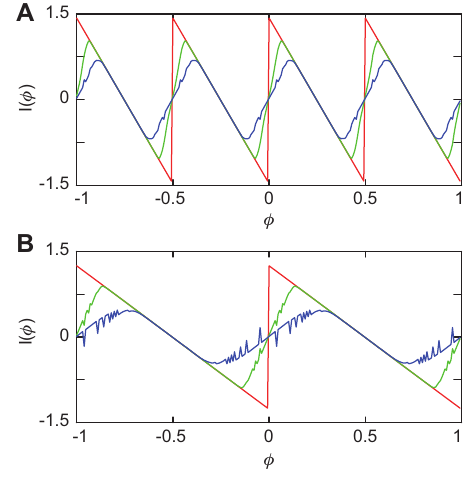
Figure 12 Persistent current as a function of fl ux φ for some ordered mesoscopic cylinders considering M = 2. (A) Half-fi lled case with N = 15. The red, green, and blue curves correspond to U = 0, 1.5, and 2, respectively. (B) Quarter-fi lled case with N = 20. The red, green, and blue curves correspond to U = 0, 2, and 3,